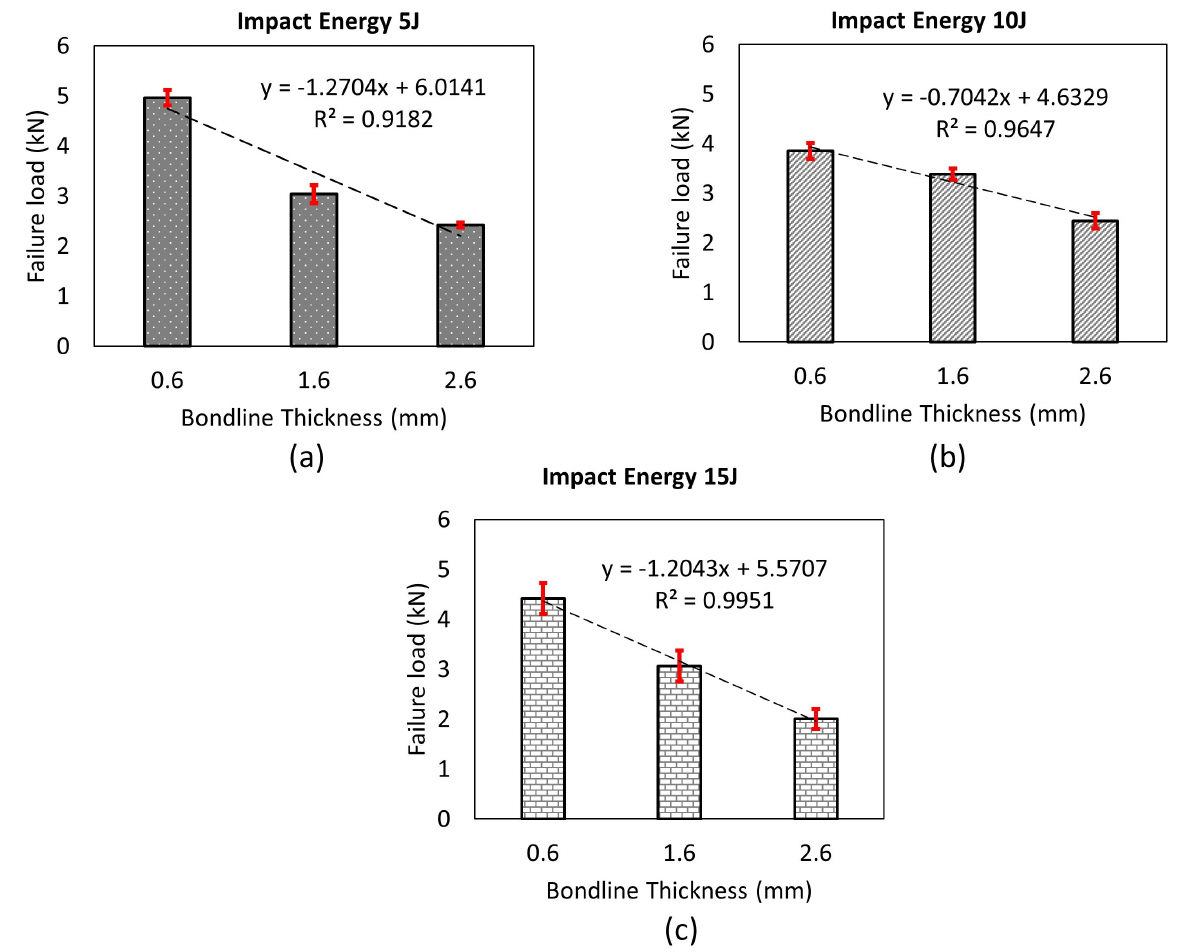
Figure 21. Comparison of post impact failure load of joints for different bondline thickness after being subjected to an impact energy of ( a ) 5 J, ( b ) 10 J, and ( c ) 15